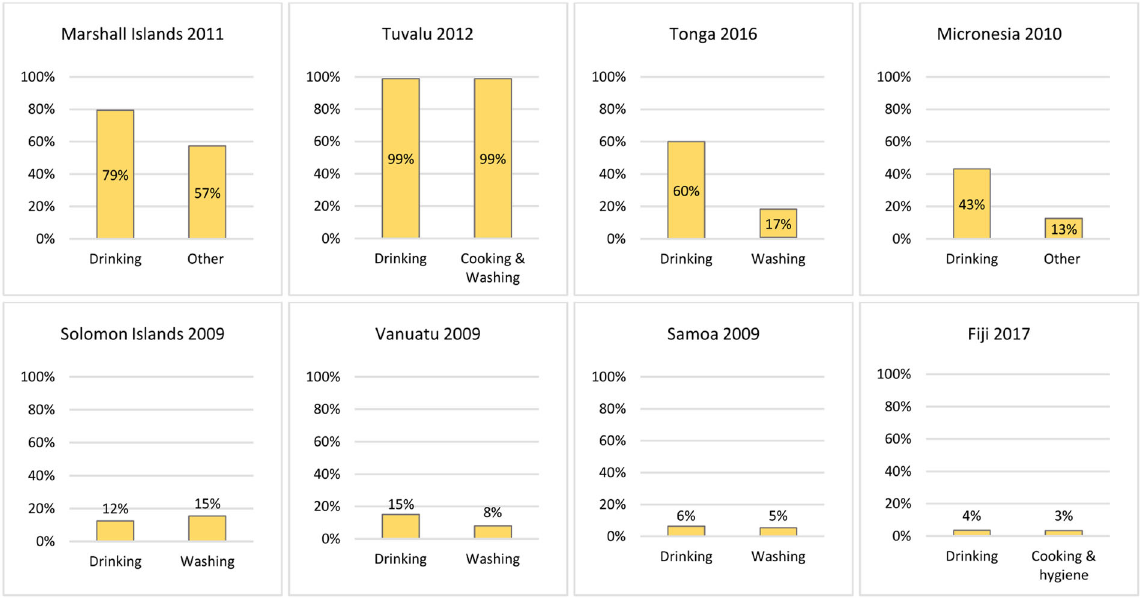
Fig. 3 Proportion of population using private rainwater tanks for drinking and other domestic purposes in the Paci fi c. Self-supply in the Paci fi c is more commonly used for drinking than non-drinking purposes, with the exception of Solomon